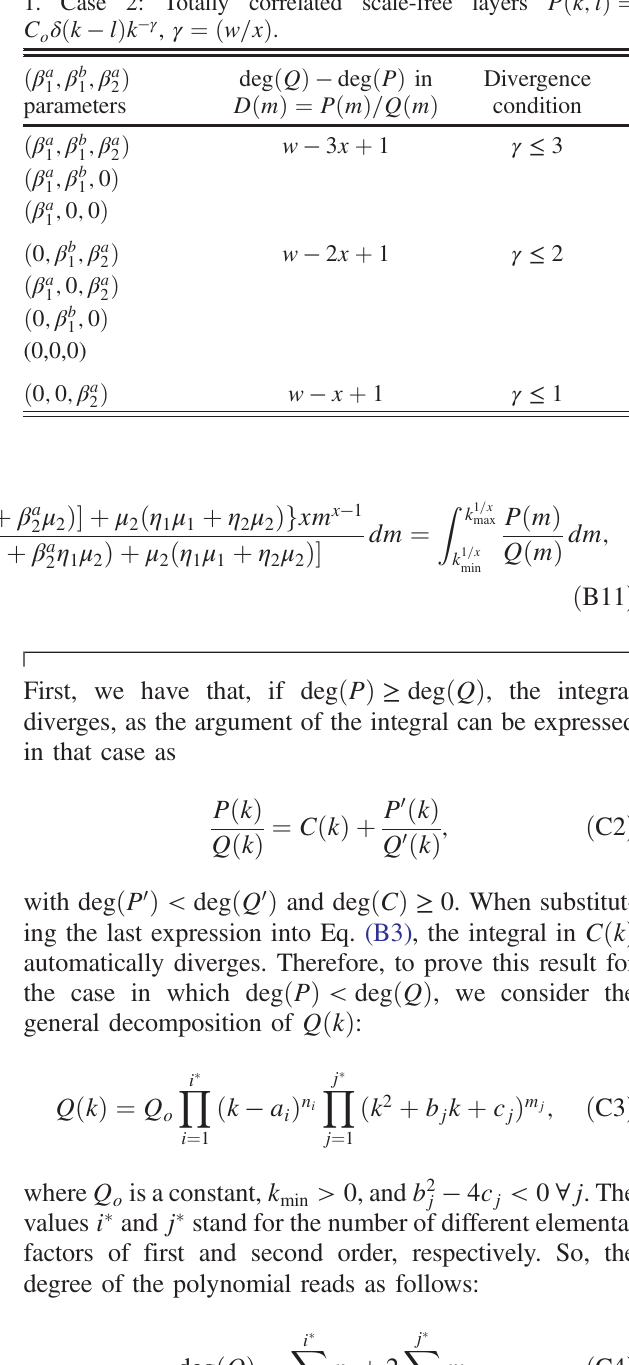
R D m Þ dm for disease 2 ð